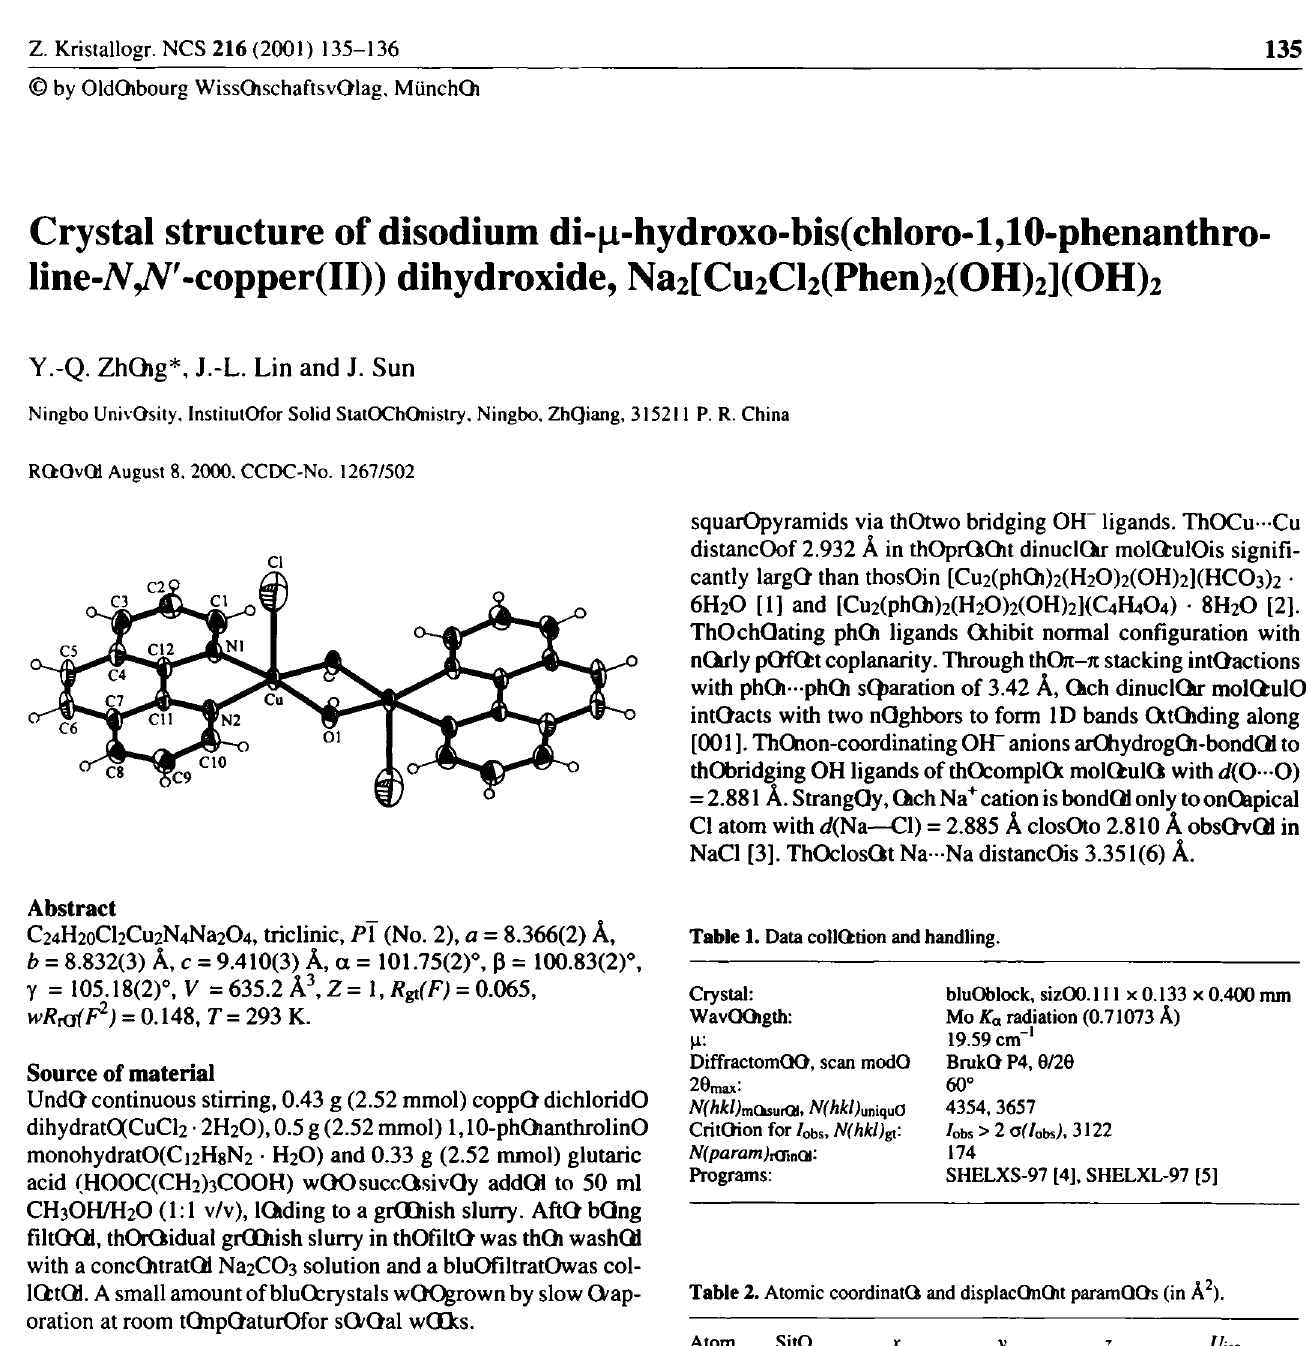
Table 1. Data colltttion and handling.